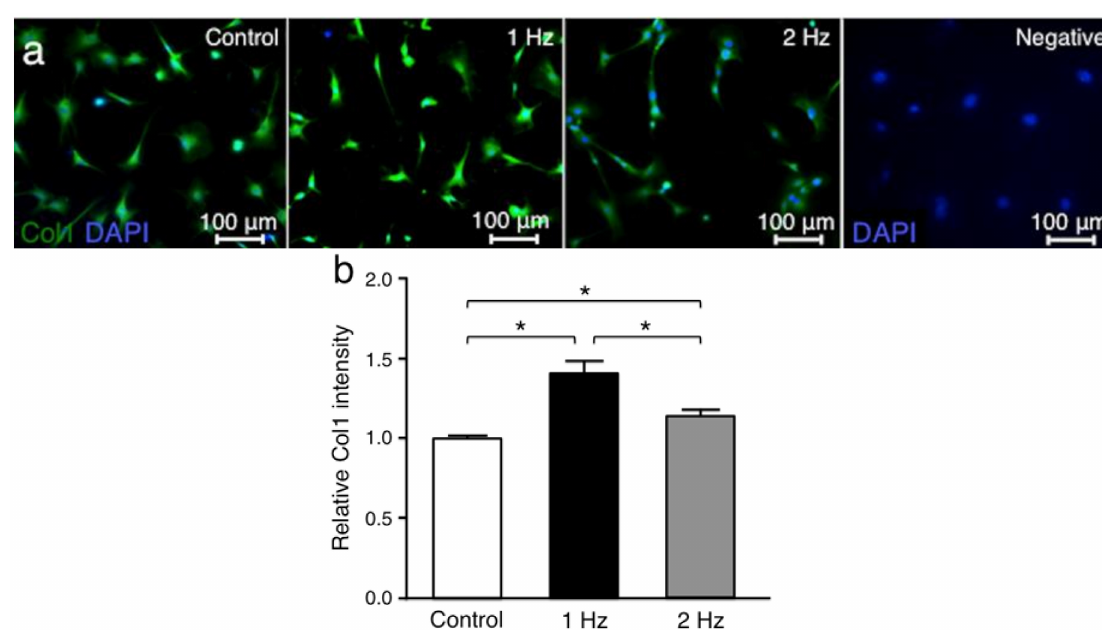
Figure 4. Collagen type 1 (Col1) fluorescence staining in overlay with nucleus coloration at di ff erent tensile frequencies. Comparison of representative immunofluorescence labelings of Col1 (green) among the three groups: Cells cultured without stretching (control), with stretching at 1 Hz, and with stretching at 2 Hz ( a ). For negative control, primary antibody was omitted. 5% stretch was applied for 3 h. The intensity of Col1 was compared among the three groups ( b ). Cell nuclei were counterstained with DAPI (blue). The values of control were set to 1 ( n = 6; mean + SEM). * p < 0.05 indicates significance. SEM, standard error of the